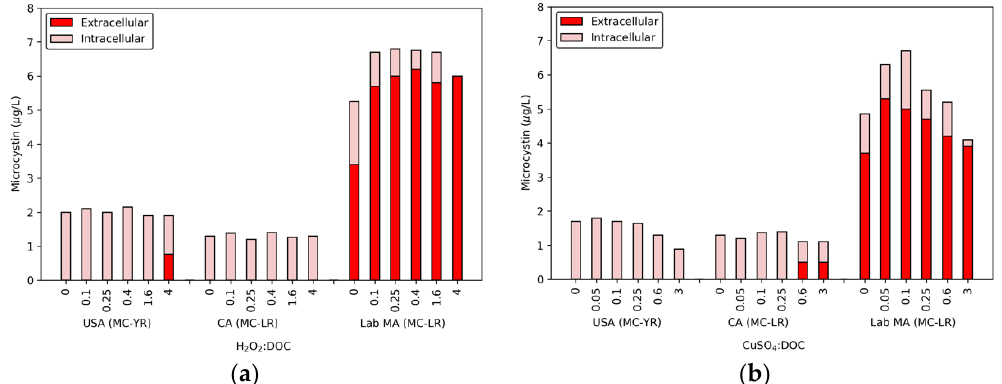
Figure 1. Release of intracellular MCs from the USA bloom, CA bloom, and the lab-cultured MA after a 24 hour exposure to ( a ) five H 2 O 2 :DOC and ( b ) five CuSO4:DOC dose